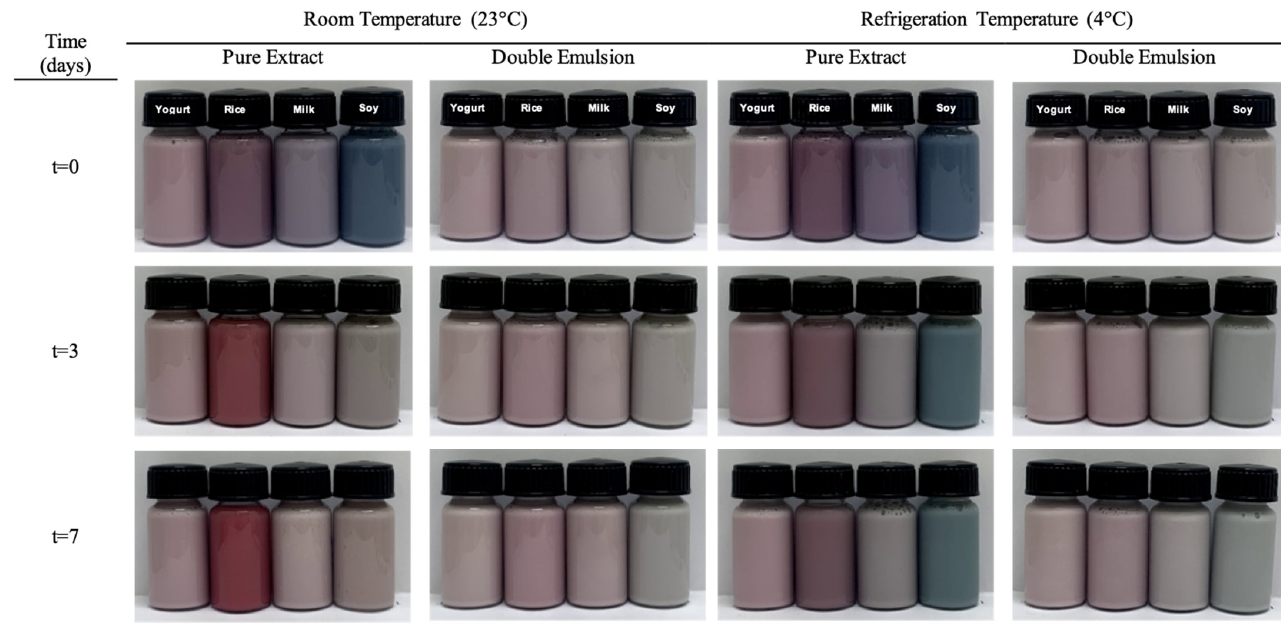
Figure 2. Photographic record of the food drinks yogurt (pH 4.65), rice (pH 6.01), milk (pH 6.47), and soy (pH 7.92) added with the free extract and the coloring emulsion as a function of time and temperature (temperature of 4 °C and 23 °C and time of 0, 3 and 7